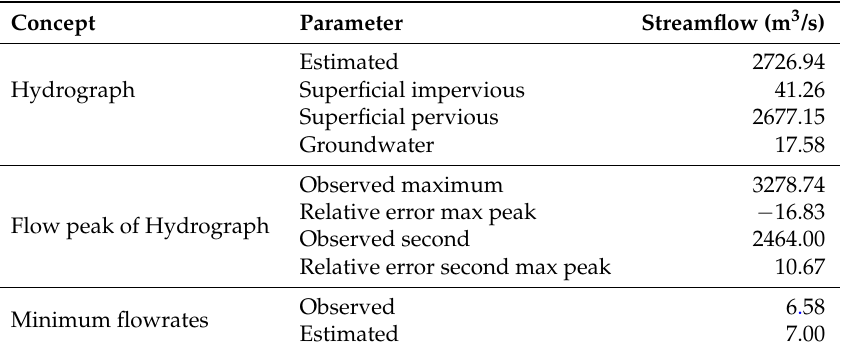
Table 5. Specific hydrograph results for instance 6.2CV (Rio Bermejo, Argentina), Clark model